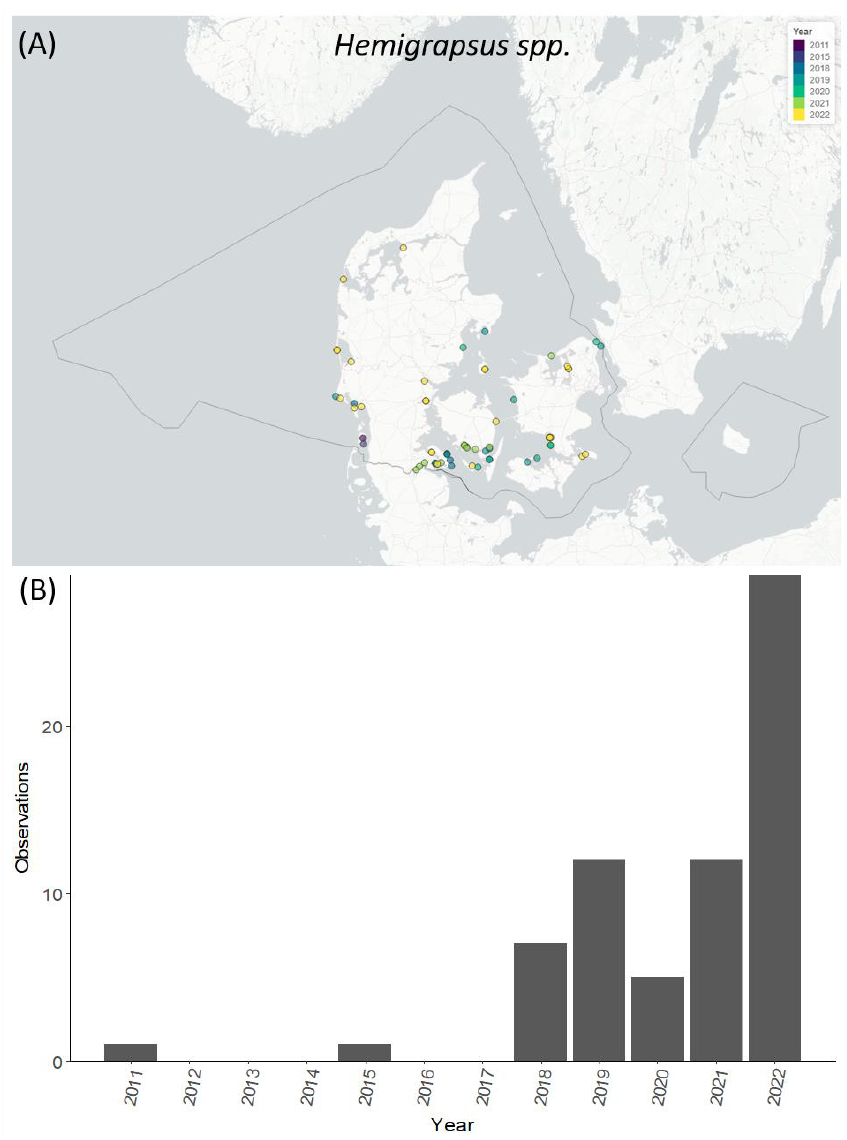
Figure 15. Distribution of Hemigrapsus sanguineus and H. takanoi 2011–2022 ( A ); occurrences of Hemigrapsus spp. during the same time interval ( B ). Data from Arter.dk and from ICES WGITMO annual national reports for Denmark.